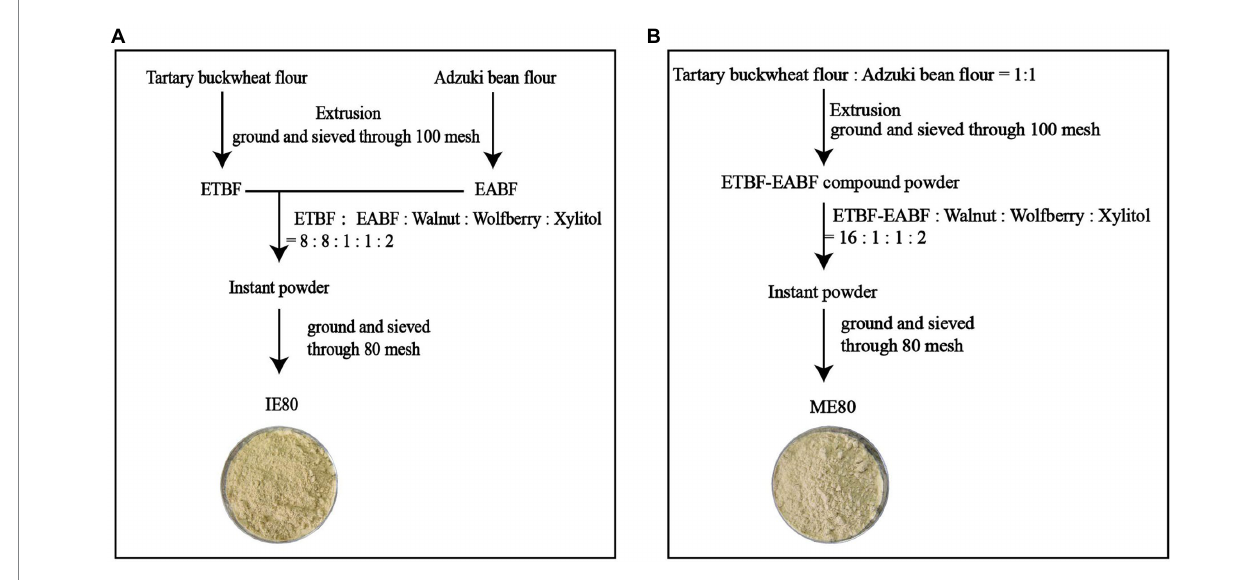
FIGURE 1 Simplified flow diagram of instant powder preparation procedures. (A) individual extrusion; (B) mixing extrusion. ETBF, extruded Tartary buckwheat flour; EABF, extruded adzuki bean flour. ETBF-EABF, mixed extrudates of Tartary buckwheat flour and adzuki bean flour; IE80, instant powder obtained with individual extrusion, 80 mesh; ME80, instant powder obtained with mixing extrusion, 80